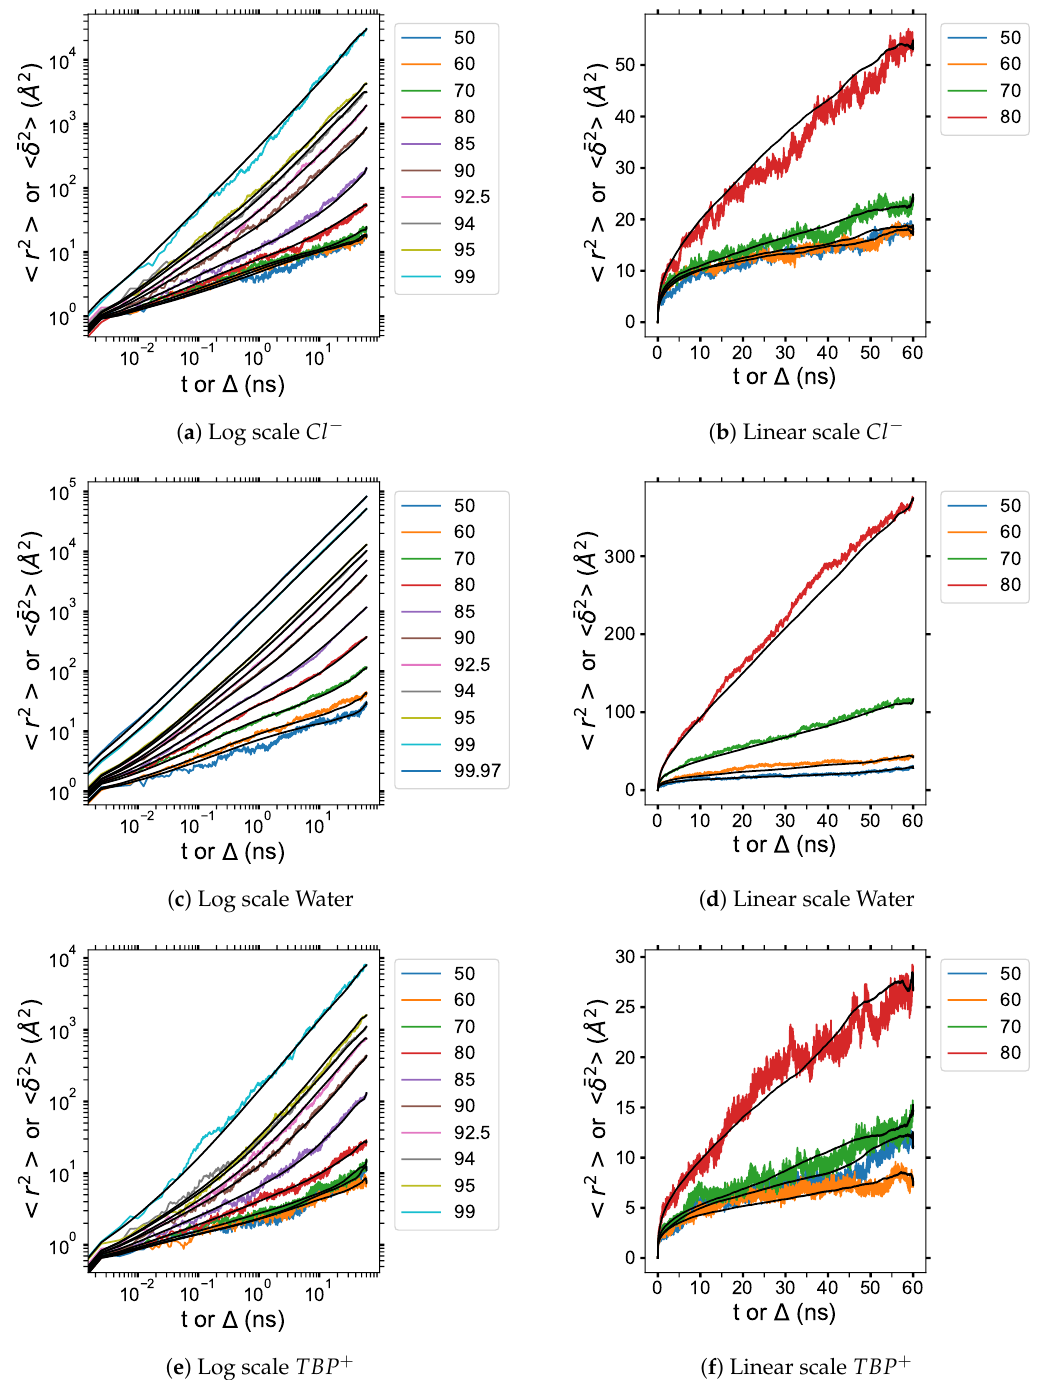
Figure A9. MSD vs. particle-averaged TAMSD of the water, TBP and Cl in TBPCl–water at p = 1atm and T = 300K as a function of water concentration: ( a ) MSD and particle-averaged TAMSD of Cl − plotted on a log scale; ( b ) MSD and particle-averaged TAMSD of Cl − plotted on a linear scale; ( c ) MSD and particle-averaged TAMSD of water plotted on a log scale; ( d ) MSD and particle-averaged TAMSD of water plotted on a linear scale; ( e ) MSD and particle-averaged TAMSD of TBP + plotted on a log scale; ( f ) MSD and particle-averaged TAMSD of TBP + plotted on a linear scale. The colored lines are the MSDs, and the black lines are the particle-averaged